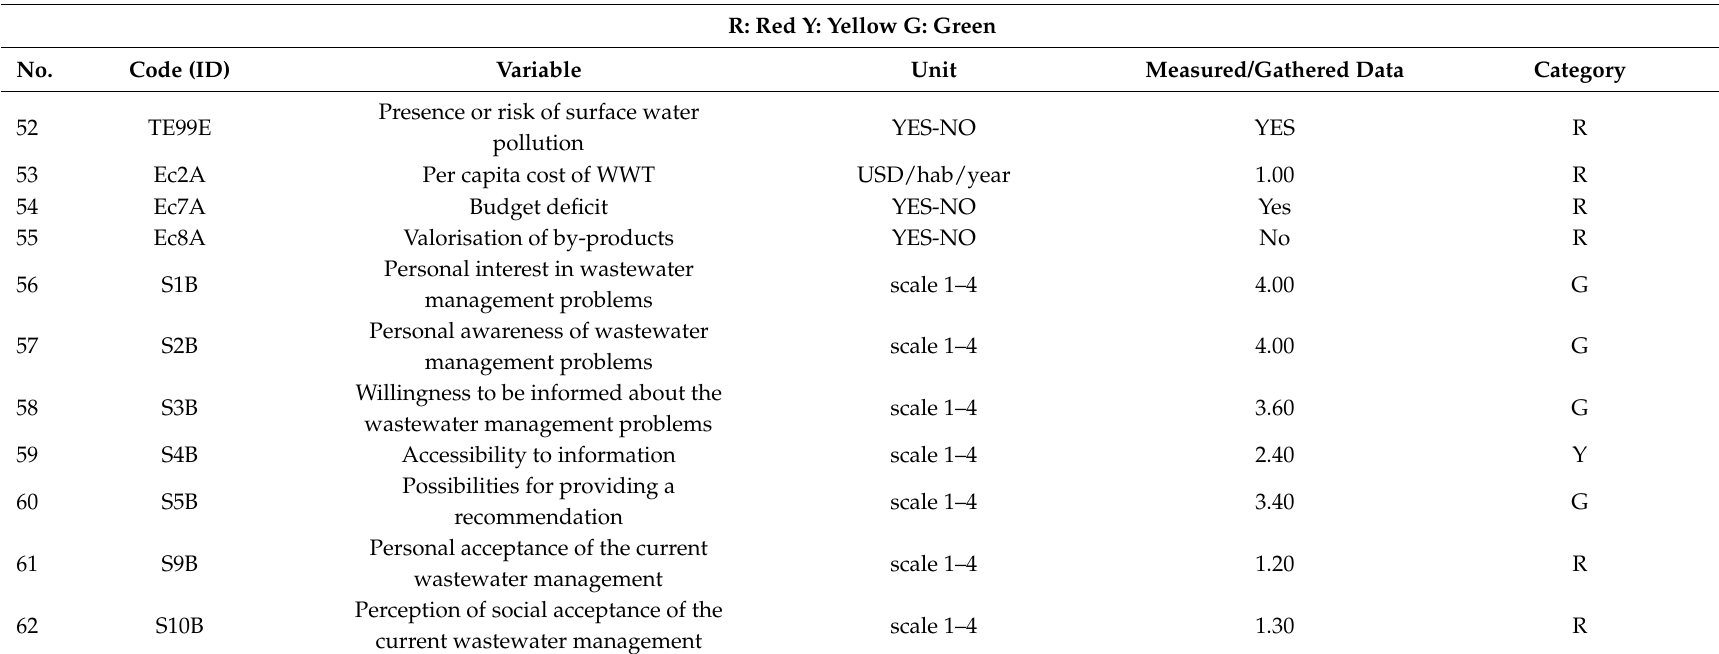
R: Red Y: Yellow G: